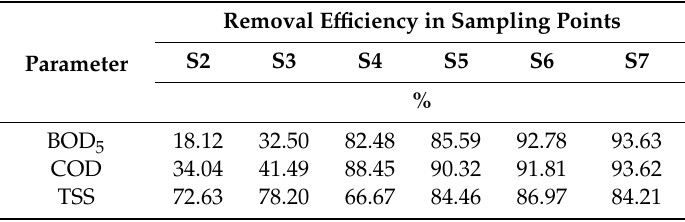
Table 3. Removal e ffi ciency of selected parameters in the Kostanay wastewater treatment